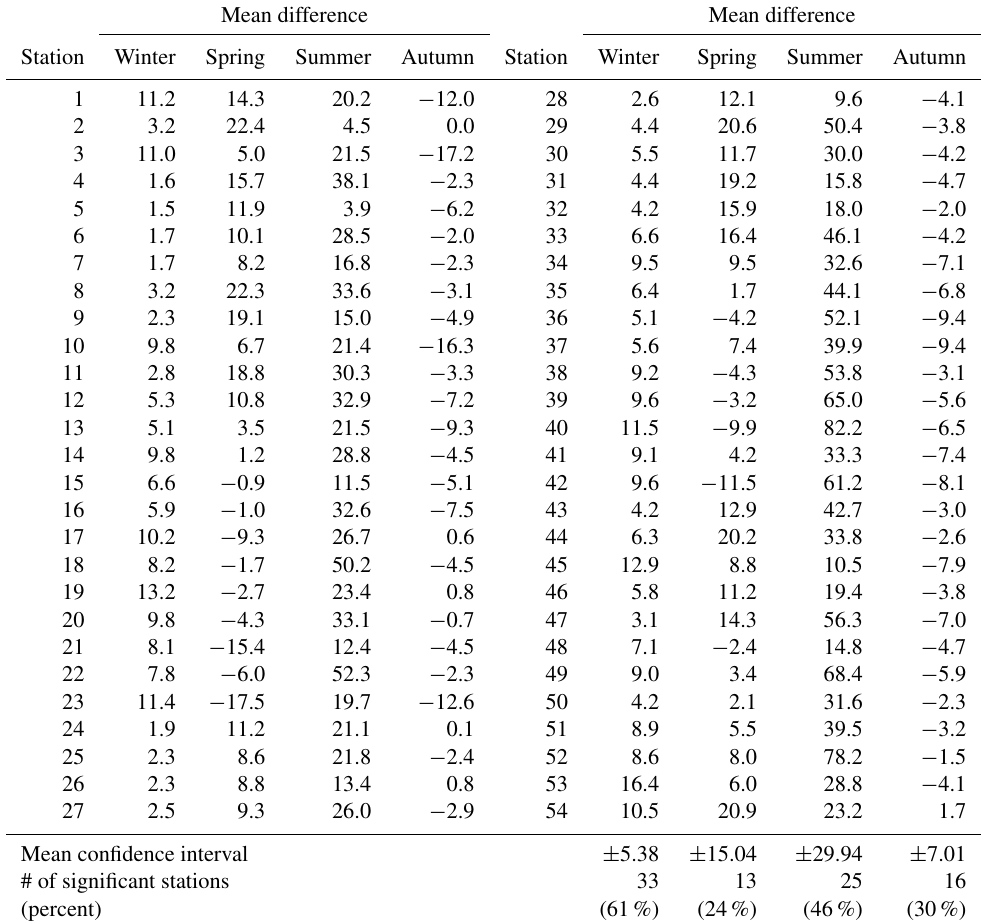
Table 1. Mean precipitation difference of the observed and simulated data for seasonal data over all the employed stations in South Korea in case of + 1.0 ◦ C mean temperature increase.